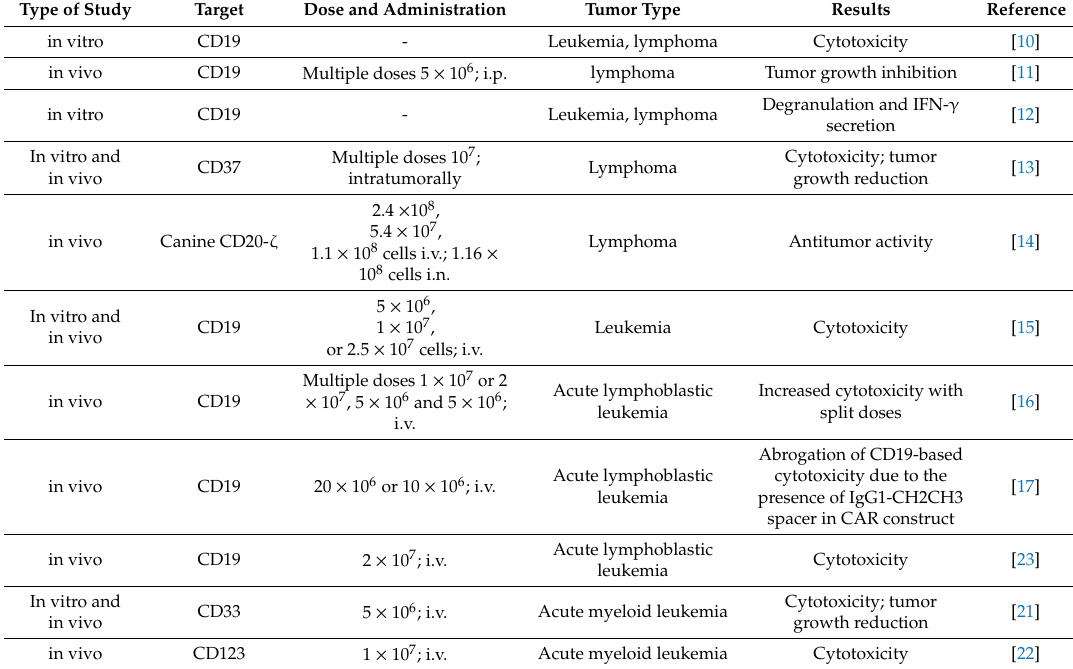
Table 1. Preclinical studies regarding the e ff ects of IVT mRNA CAR T cells in hematologic